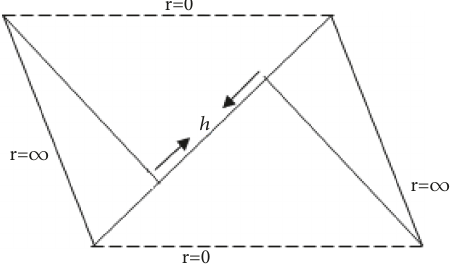
Figure 1: Penrose diagrams for an eternal black hole with a perturbation.